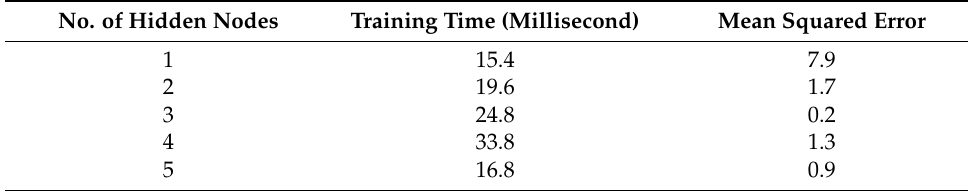
Table 1. Training performance simulation on different number of hidden nodes. No. of Hidden Nodes Training Time (Millisecond) Mean Squared Error